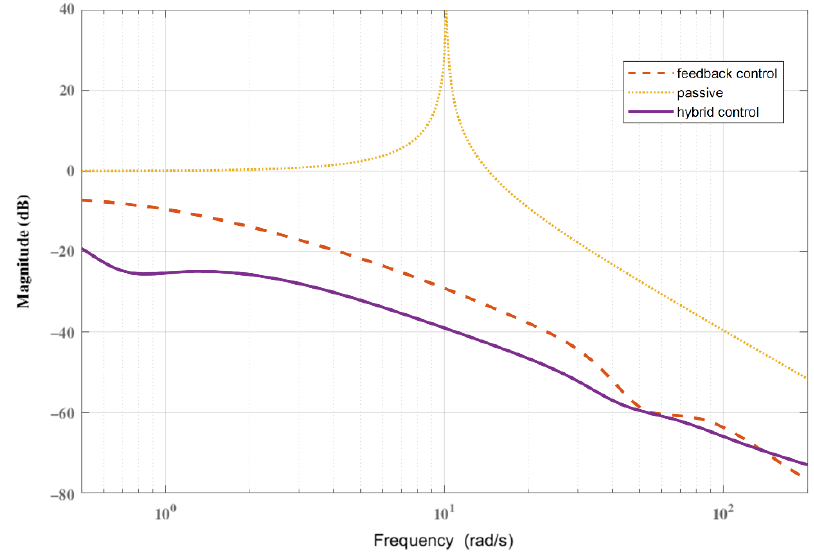
Figure 6. Bode diagram of transmissibility with different control methods.